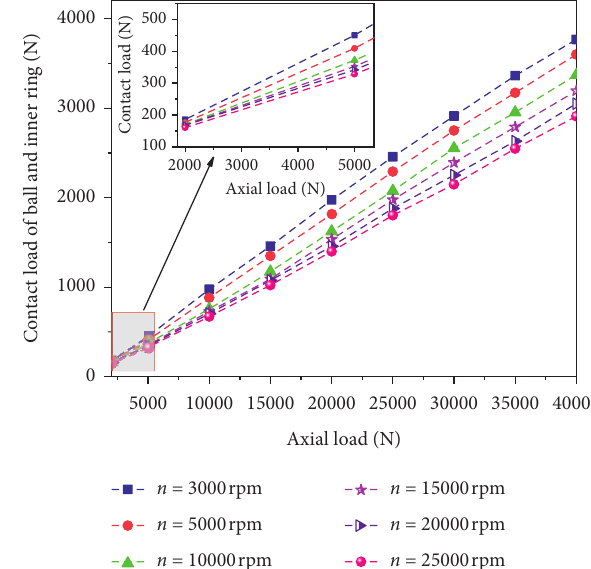
Figure 15: The contact force between inner ring and rolling ball.